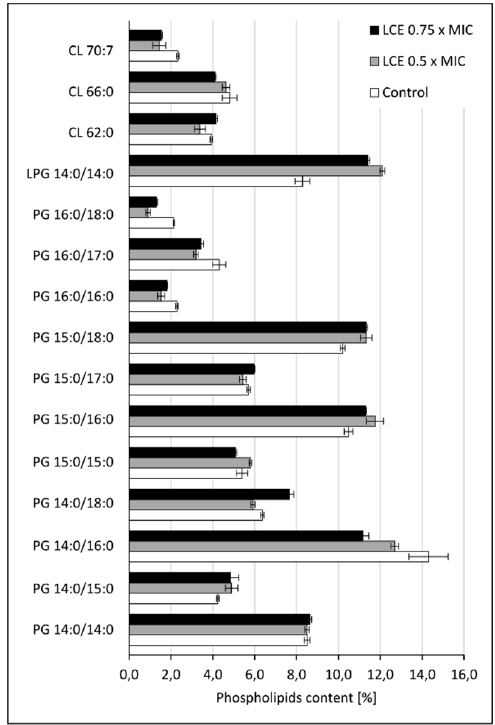
Figure 5. Content of the main phospholipid species (achieving above 2% in control) in cell membrane of control S. aureus 8325-4 cells or the cells treated with L. cardiaca L. extract (LCE) at 0.5 × MIC or 0.75 × MIC for 24 h, measured by HPLC – MS. PG—phosphatidylglycerol, LPG—lysyl-phosphatidylglycerol, CL—cardiolipin.